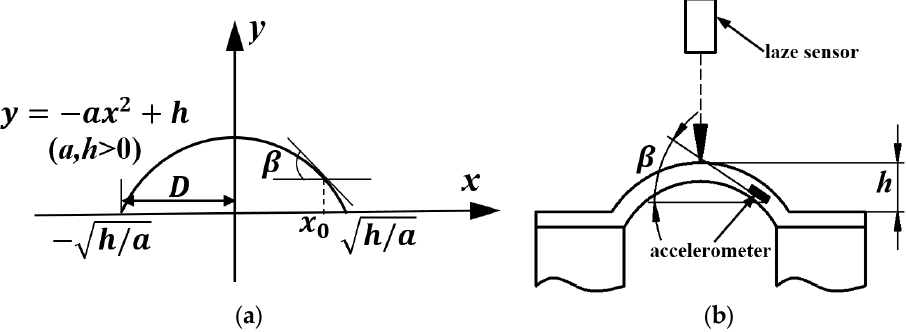
Figure 10. Schematic diagrams to calculate output voltage V x under static pressurization ( a ) Skin’s surface approximated by quadratic curve. ( b ) Schematic drawing of experimental setup for measuring inflated skin’s height.